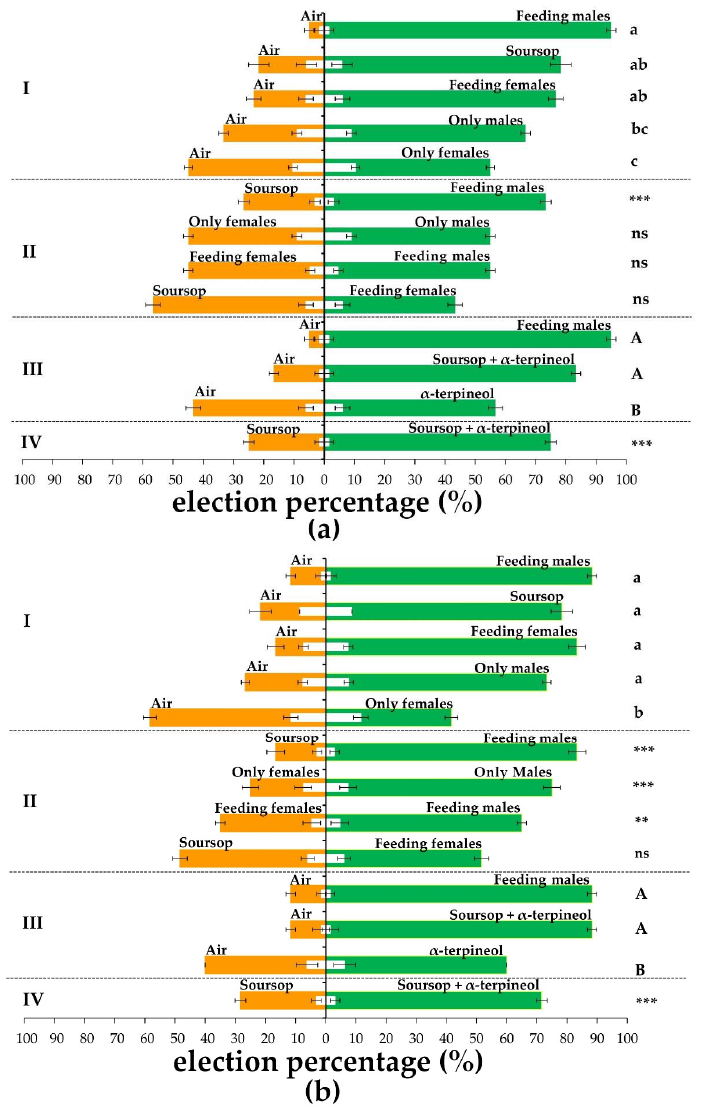
Figure 1. Olfactory preference of males and females of Optatus palmaris to different odors as single or double stimulus sources. ( a-I ), male preferences to single stimulus source vs. air. ( a-II ), male preference when two odor source are challenged against each other. ( a-III ), male preference to one stimulus source involving α -terpineol against air. ( a-IV ), male preference to soursop challenged against soursop supplemented with α -terpineol. Data represent the selection percentage of males to an odor stimulus ( n = 4). Horizontal black bars indicate standard error values. Treatments with the same letters are not significantly different in a ( a-I ) Tukey test ( p < 0.05), ( a-II ) G-test (G < 0.05), *** < 0.0001, ( a-III ) Tukey test ( p < 0.05), and ( a-IV ) G-test (G < 0.05), *** < 0.0001. ( b-I ), female preferences to single stimulus source vs. air. ( b-II ), female preference when two odor source are challenged against each other. ( b-III ), female preference to one stimulus source involving α -terpineol against air. ( b-IV ), female preference to soursop challenged against soursop supplemented with α -terpineol. Data represent the selection percentage of males to an odor stimulus ( n = 4). Horizontal black bars indicate standard error values. Treatments with the same letters are not significantly different in a ( b-I ) Kruskal–Wallis/Bonferroni test ( p < 0.05), ( b-II ) G-test (G < 0.05), ** < 0.001, *** < 0.0001, ( b-III ) Kruskal-Wallis/Bonferroni test ( p < 0.05), and ( b-IV ) G-test (G < 0.05), *** < 0.0001. The statistical analysis was performed separately for males’ and females’ data. White bars represent average values ( n = 4) of non-responding insects registered in each preference test. Horizontal black bars indicate standard error values. The non-responding insect values were compared for the first three sections (I, II, and III) with an ANOVA test. There were no statistical differences among non-responding insect values in any set of experiments analyzed ( p >